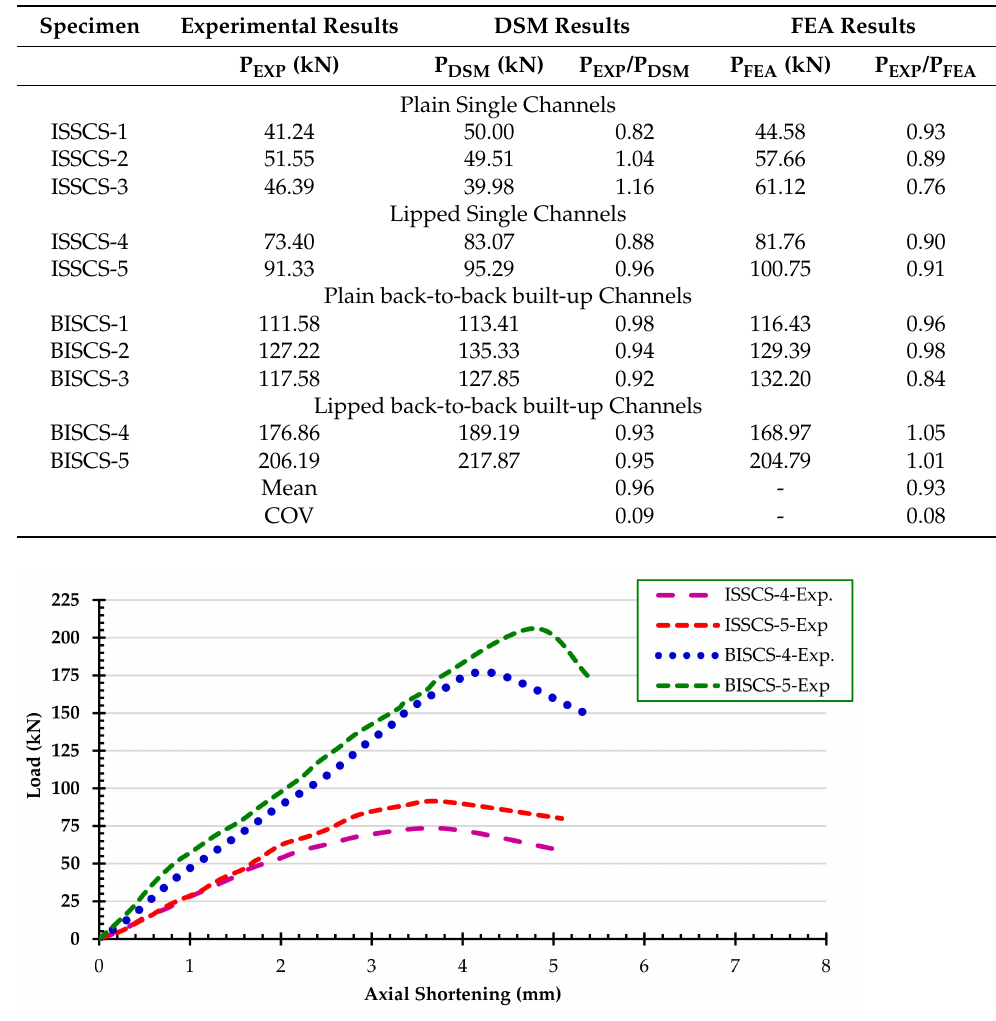
Figure 9. Typical load versus axial shortening curves from the experimental